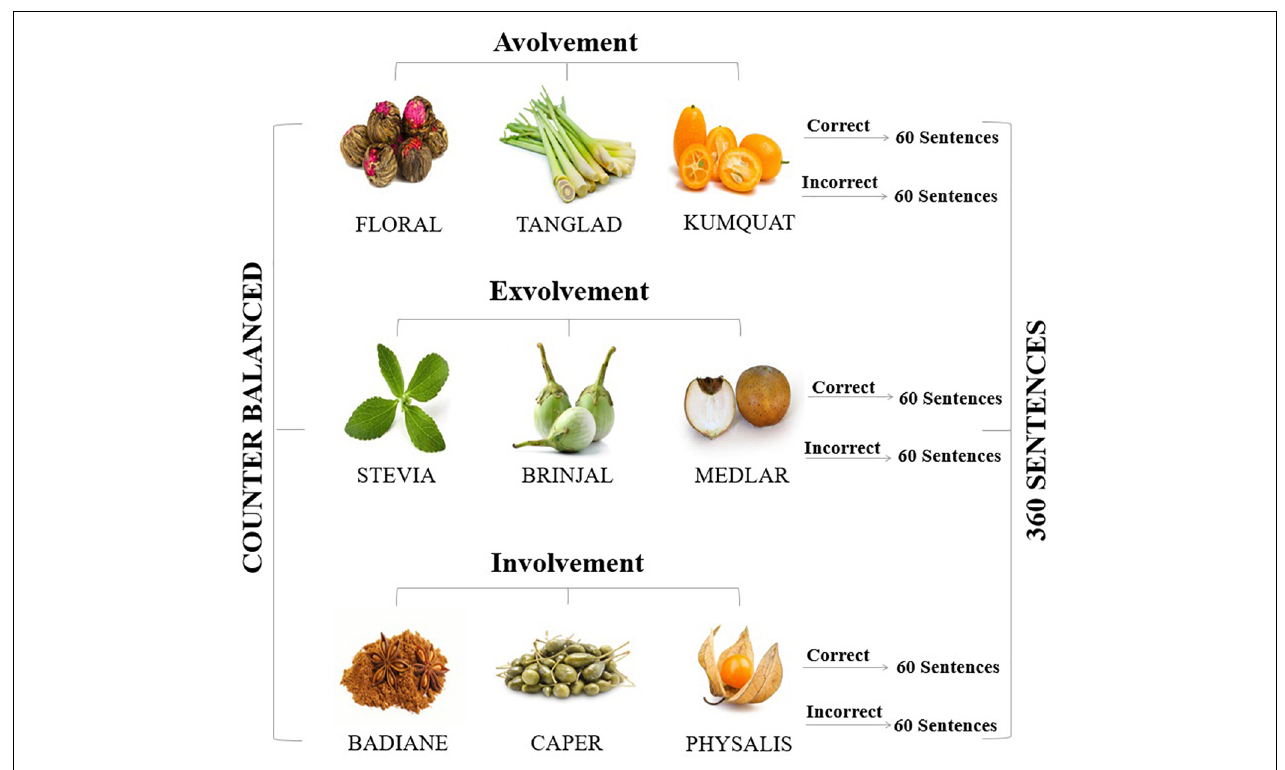
FIGURE 1 | Sample instruction for various sense combinations.